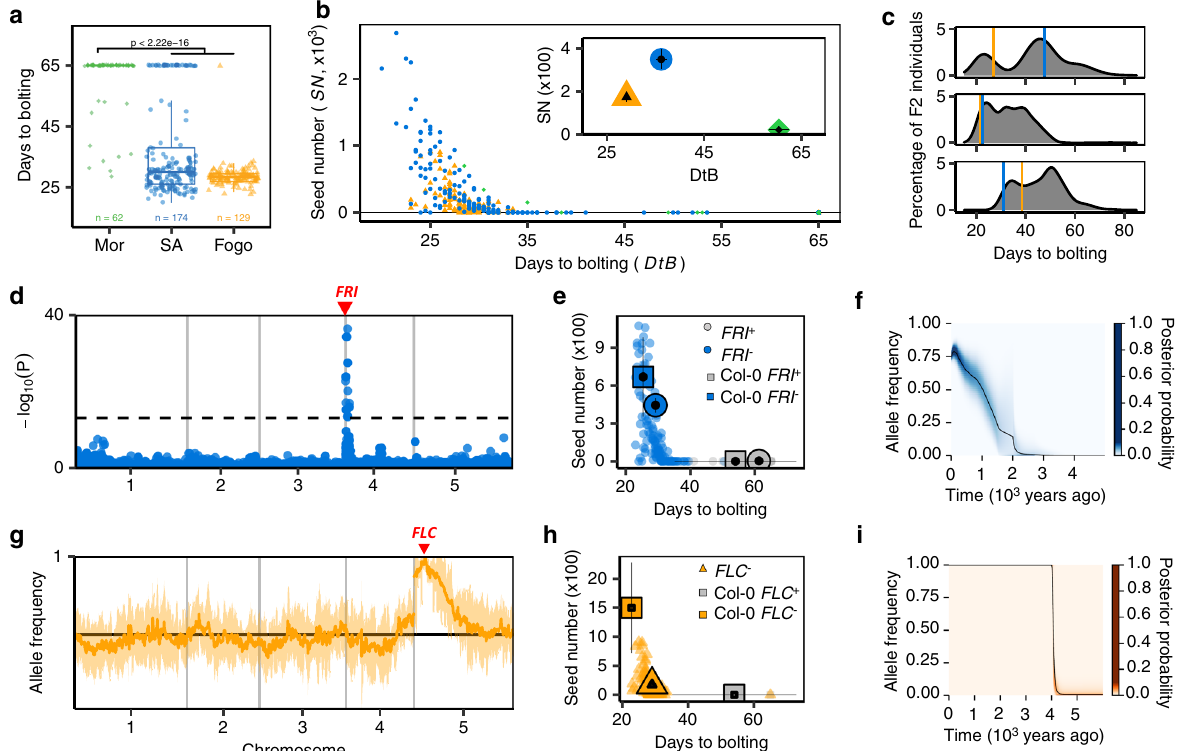
Fig. 7 Adaptation through parallel reduction in fl owering time in CVI. a Bolting time in CVI relative to Morocco with two-sided MWW test to compare distributions ( p -value < 2.2 × 10 − 16 ). Boxplots show median (centre), 1st and 3rd quartiles (lower and upper bound, respectively). Whiskers represent 95% CI. b Days to bolting versus fi tness (seed number); inset: means and 95% CIs. c Bolting time is transgressive across islands in three inter-island F2 populations. Vertical lines represent medians of days to bolting across replicates of the Santo Antão (blue) and Fogo (orange) parents. d Bolting time GWAS in Santo Antão. Dashed line represents Bonferroni-corrected genome-wide signi fi cance. e Effects of FRI alleles on bolting time and seed number under simulated CVI conditions ( n = 189). Small symbols represent individual lines, large symbols population means with 95% CI (whiskers). f Inferred allele frequency trajectory of the derived FRI 232X in Santo Antão. The black curve represents the posterior mean of the allele frequency and the coloured area the posterior distribution. g Frequency distribution of the Fogo allele in an early fl owering bulk from an inter-island F2 population reveals a peak at FLC . Median frequency per window (line) and one standard deviation (shading) are shown. h Effects of FLC alleles on bolting time and seed number under simulated CVI conditions ( n = 146) as in ( e ). i Inferred allele frequency trajectory of the derived FLC 3X allele in Fogo, as in ( f ). Source data are provided as a Source Data fi